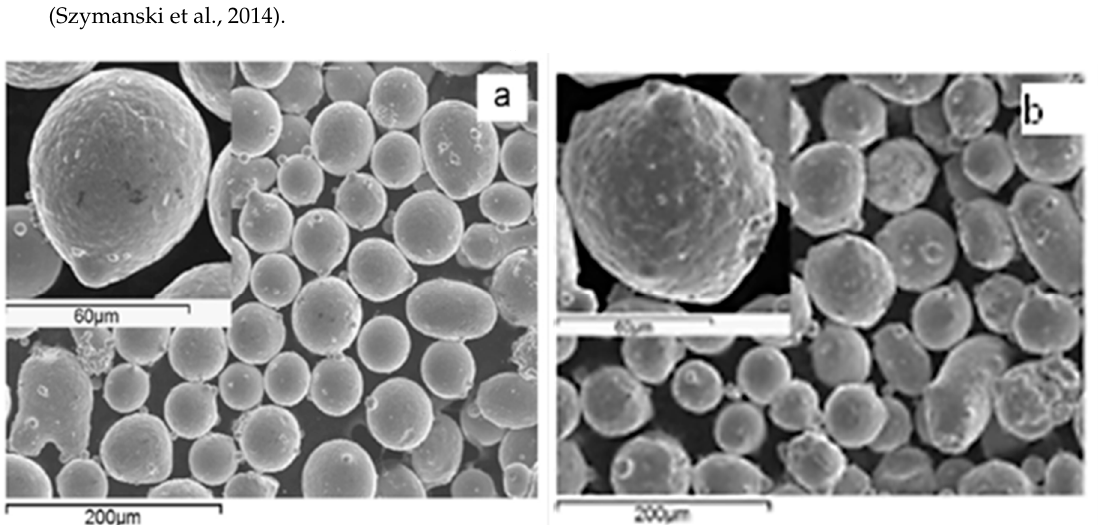
Figure 7. Titanium Carbide coating on austenitic steel produced by the way of : a ) spraying, b )agglomerating and sintering, c )mechanical alloying, d )high temperature synthesis (Szymanski et al., 2014).